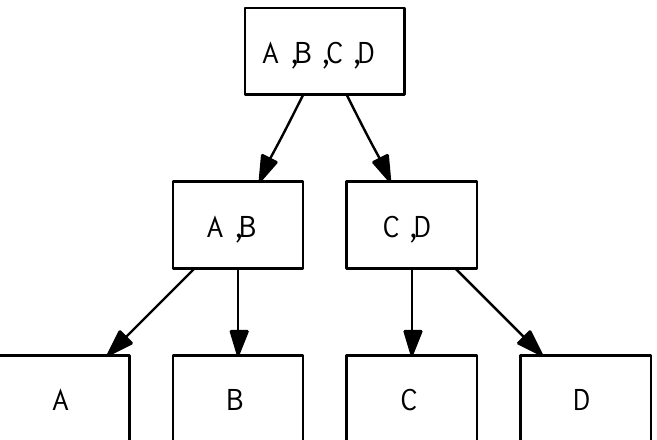
Figure 1: An example of the effect of depth weighting. Consider as an example the classification shown. Imagine we were to observe a set of objects X with labels { A, B } , and a set of objects Y with labels { A, C } . Taking X first, we prune the leaves C and D and the new leaf C, D and calculate the classification entropy. Clearly, there is a classification entropy of 1. Now looking at Y , we prune B and D and calculate the classification entropy, again it is 1. Both X and Y have a classification entropy of 1 despite the fact that X is clearly a more related set of examples lying in a more constrained subtree. In order to overcome this problem, we use the depth weighted clas- sification entropy. For this example example, consider the depth weighted classification entropy with K = 1 / 2 . Now, for X it is 1/2, whereas for Y it is 1. Thus the depth weighted entropy reflects the level in the classification at which the branching is